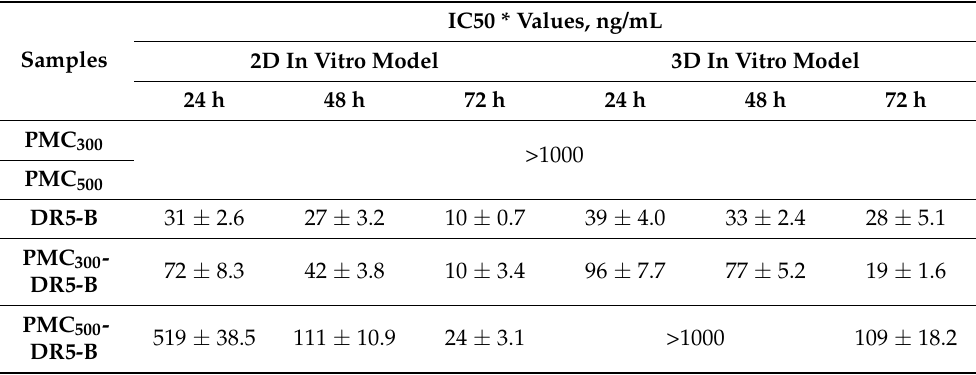
Figure 8. The cytotoxicity effects of the free capsules (PMC 300 and PMC 500 ) and the capsules modified with DR5-B (PMC 300 -DR5-B and PMC 500 -DR5-B) after incubation with human colorectal carcinoma HCT-116 cells after 24, 48 and 72 h incubation. Monolayer cell culture (a top panel) and the tumor spheroids (a lower panel). Free DR5-B protein was used as a control. MTT-test. p < 0.05 indicates significant difference according to Student’s t -test. Table 1. The IC50 values of the capsules after incubation with human colorectal carcinoma HCT-116 cells. Monolayer cell culture (2D in vitro model) and tumor spheroids (3D in vitro model). Free DR5-B protein was taken as a control. MTT-test.